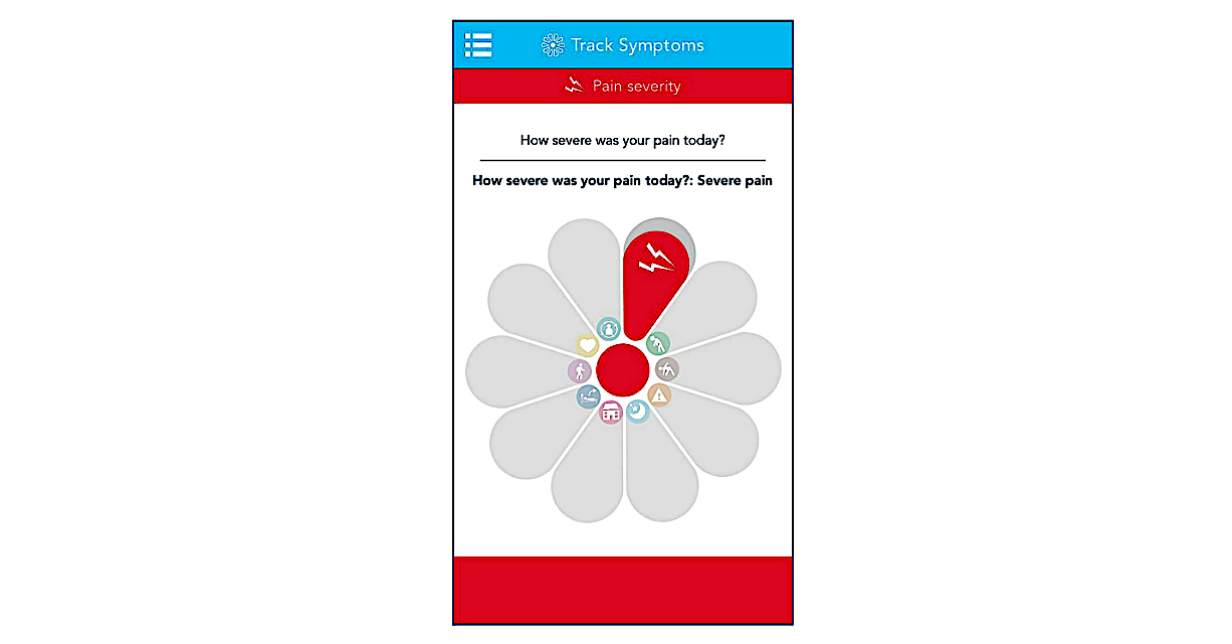
Figure 2. Screenshot of motif for daily symptom